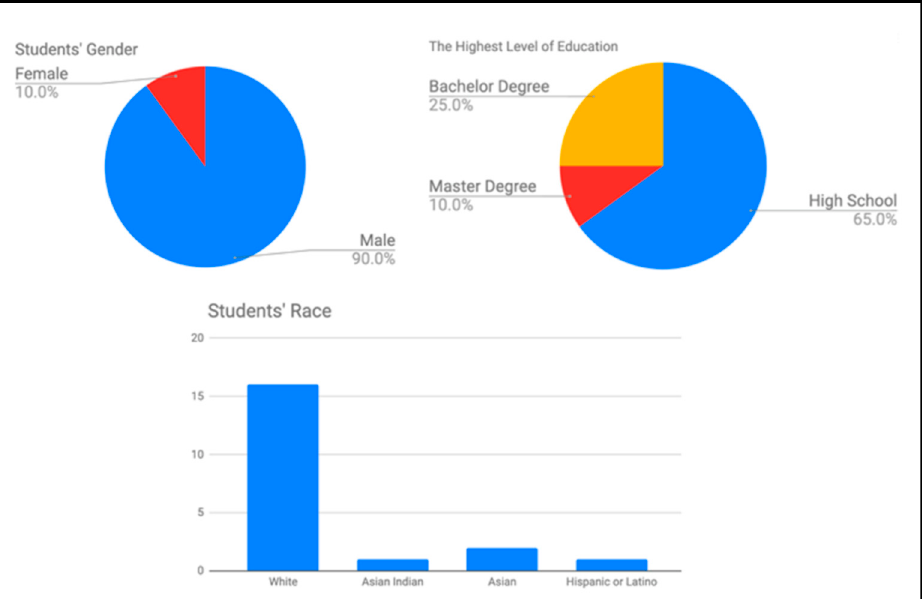
Figure 15. The demographic data of the participants.